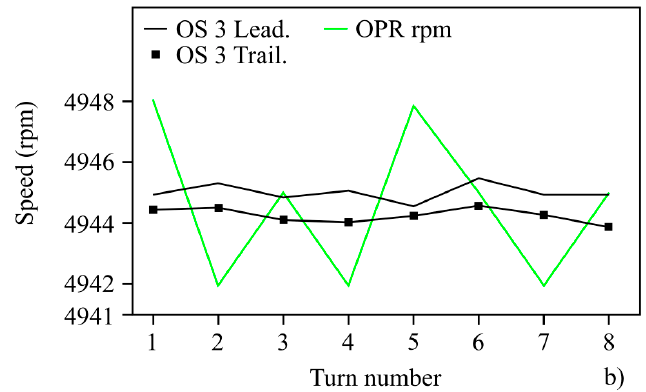
Figure 6. ( a ) Turbine instantaneous speed over several shaft turns measured by di ff erent optical sensors. The reference speed was defined by the OPR signal. ( b ) Comparison of the turbine instantaneous speed values given by OS 3 and the OPR signal.